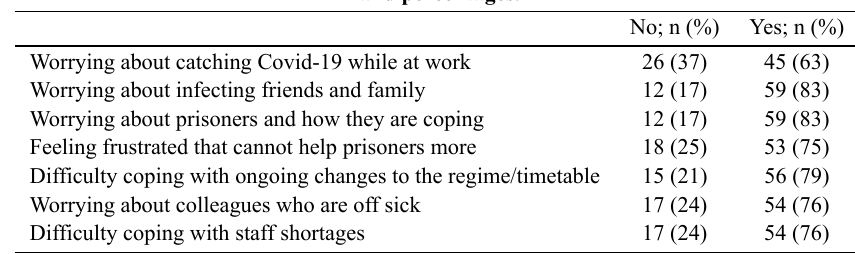
Table 6. Whether SARS-CoV-2 related changes and stressors impacted the mental health and wellbeing of staff; frequencies and percentages.